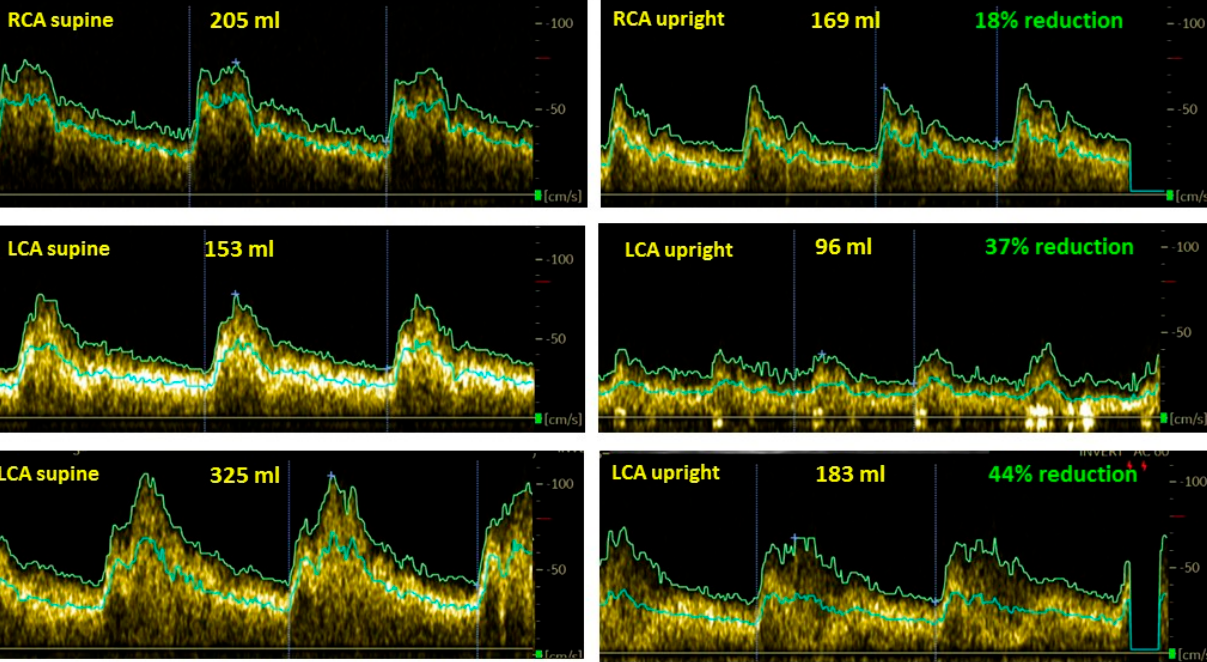
Figure 5. Examples of cerebral blood flow decrease while upright compared to supine in ME/CFS patients with an insidious onset. ( A ): female, 26 years; ( B ): female, 53 years old; ( C ): female, 32 years LCA: left carotid artery; RCA: right carotid artery.